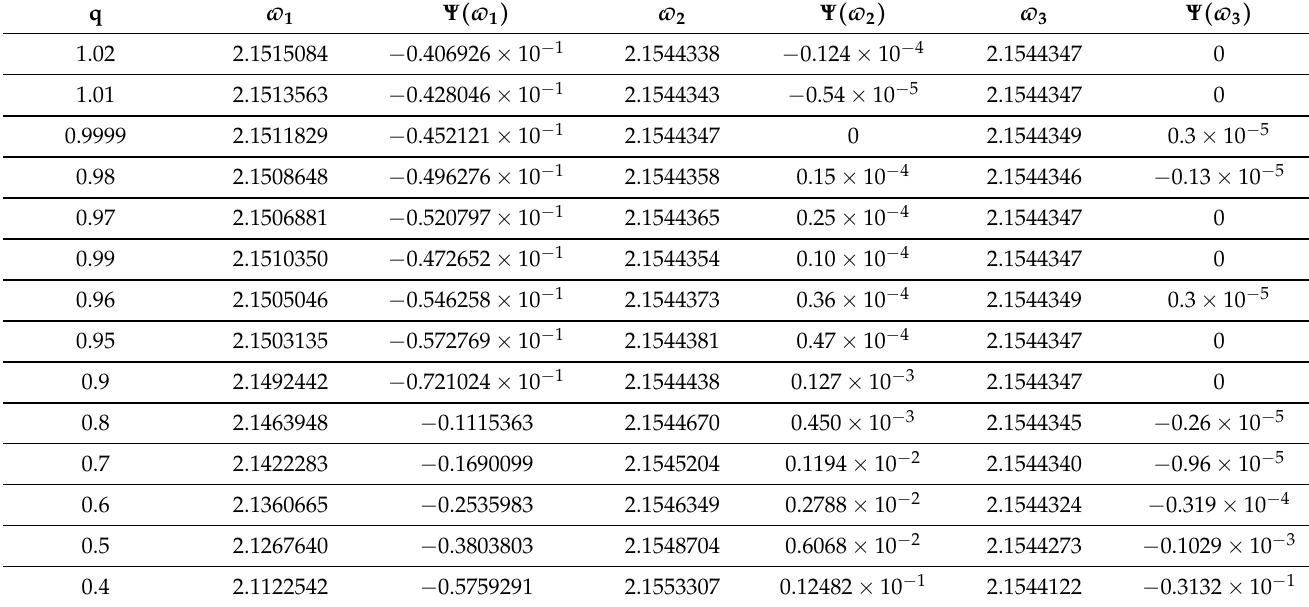
Table 1. Calculation of (cid:118) i and Ψ ( (cid:118) i ) for i = 1,2,3 and different values of q by using